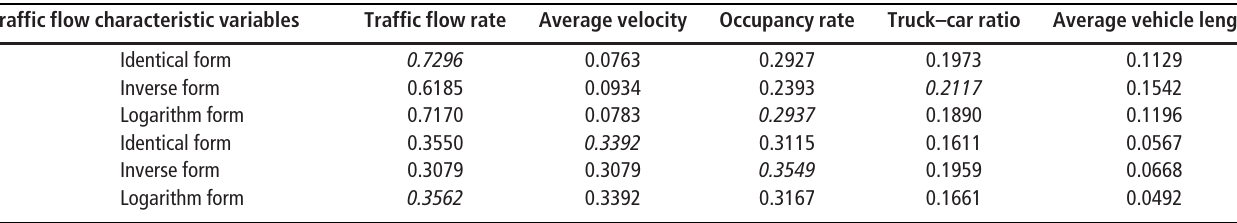
Table 6 Mean value of variable importance (HighD) Traffic flow characteristic variables